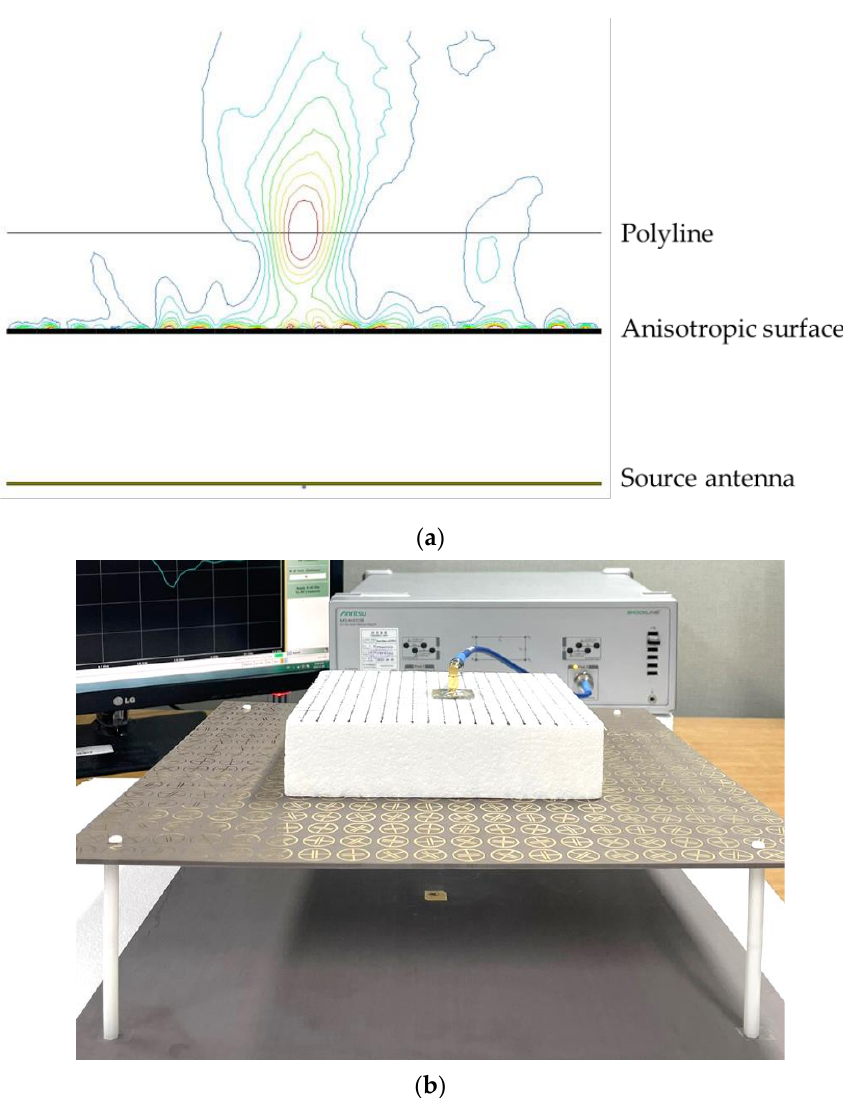
Figure 5. Photographs of fabricated transmitarray antenna. ( a ) source antenna ( b ) Anisotropic an- tenna ( c ) Transmitarray antenna.